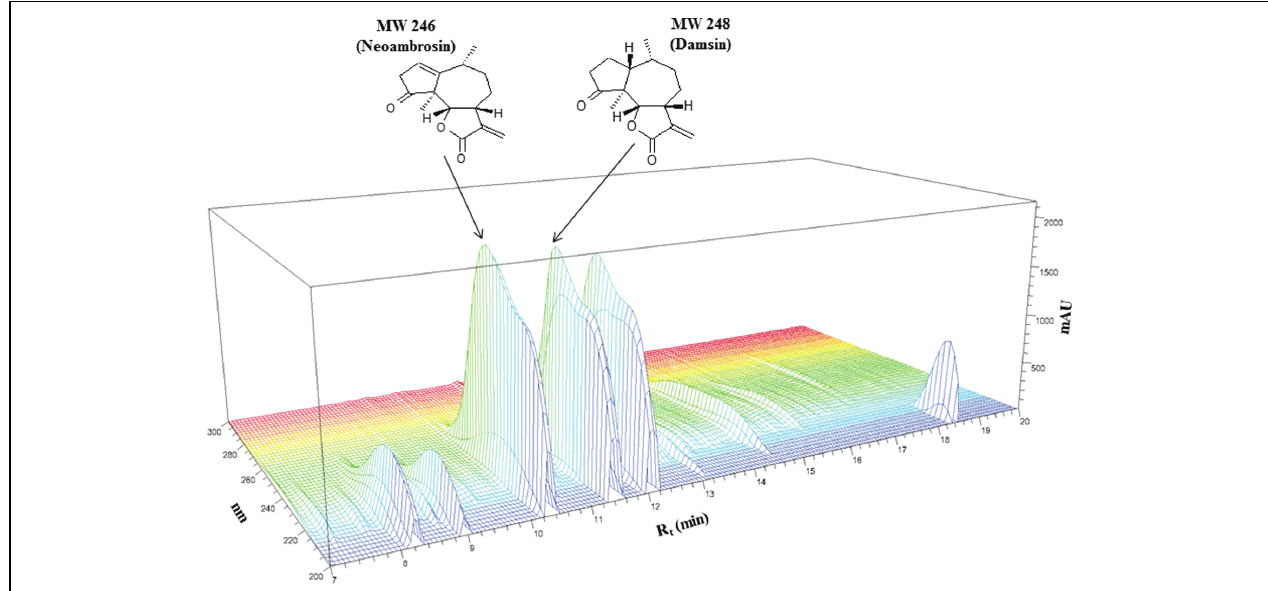
FIGURE 1 | Chemical structures of neoambrosin (1) and damsin (2) and HPLC profiling of Ambrosia maritima L. dichloromethane (DCM) extract.